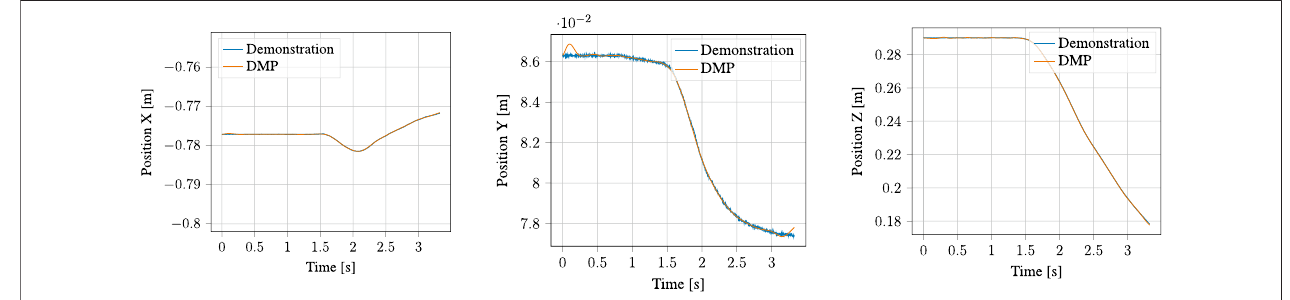
FIGURE 10 | Demonstrated position and corresponding Position DMP for the approach motion.